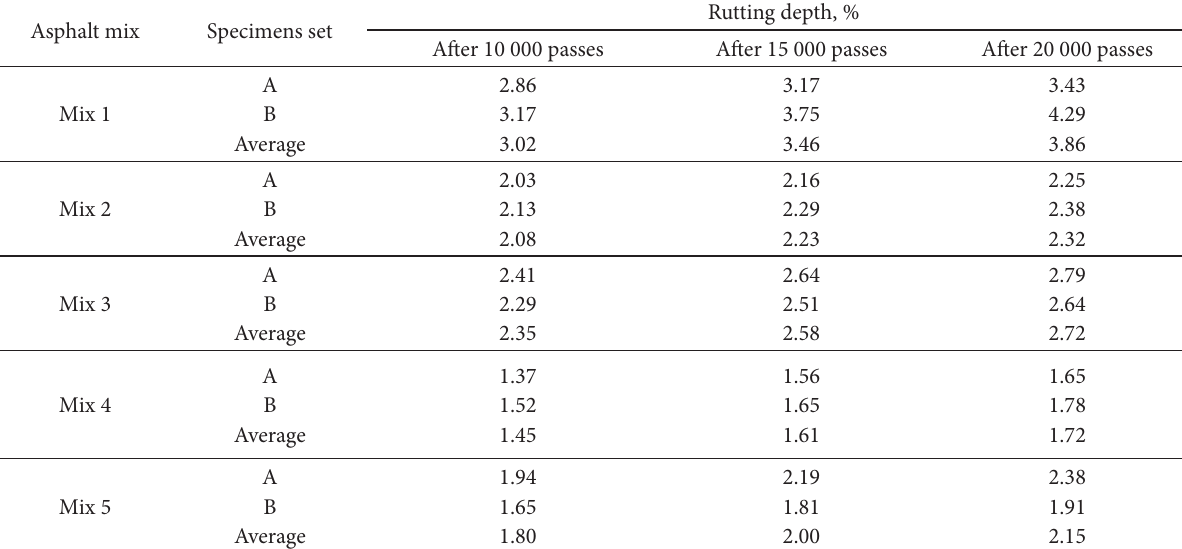
Table 6. HWRT rutting results for different HMA mixes Asphalt mix